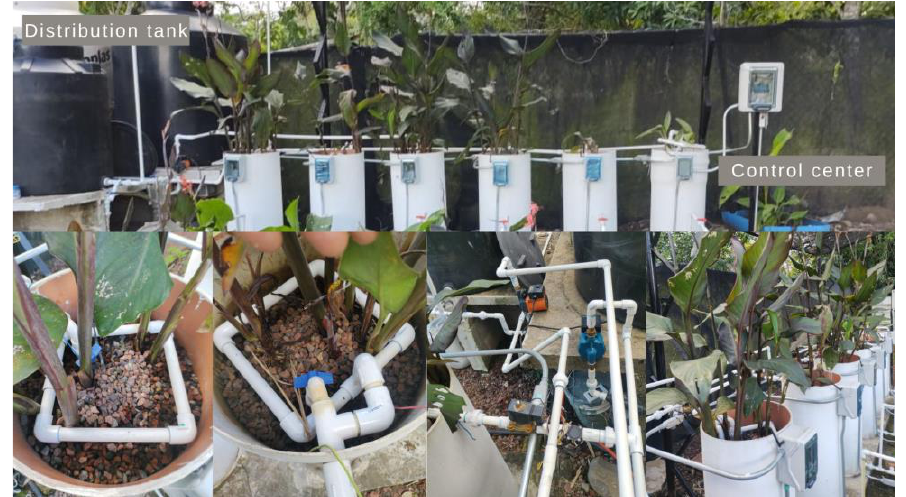
Figure 3. Control system for the wastewater supply in the CWs.